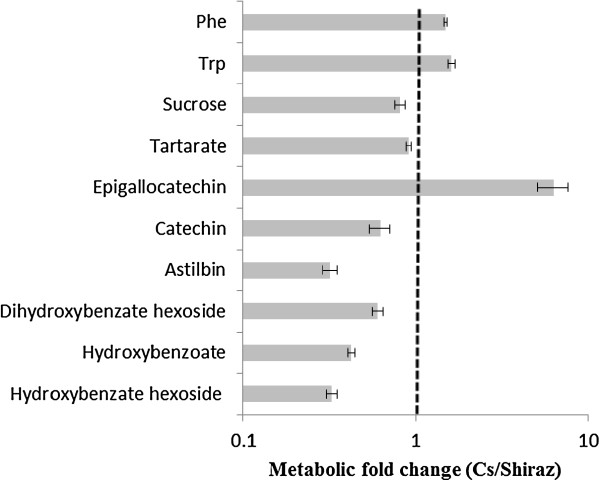
Metabolites in the sap of Cabernet Sauvignon (Cs) and Shiraz in irrigated plots. Values are the fold change Cs/Shiraz. Presented is the analysis of the leaves of irrigated plants sampled on day 4 of the experiment. Shown are metabolites that were significantly different (p-value < 0.05) between the cultivars in the irrigated plots on at least one of the sampling days and that showed similar trends throughout the experiment (Additional file 3: Table S3). Columns represent means ± SE (n = 6). The dashed line marks values of fold change equal to ‘one’, i.e., no change between relative metabolite contents of Shiraz and Cabernet Sauvignon cultivars.